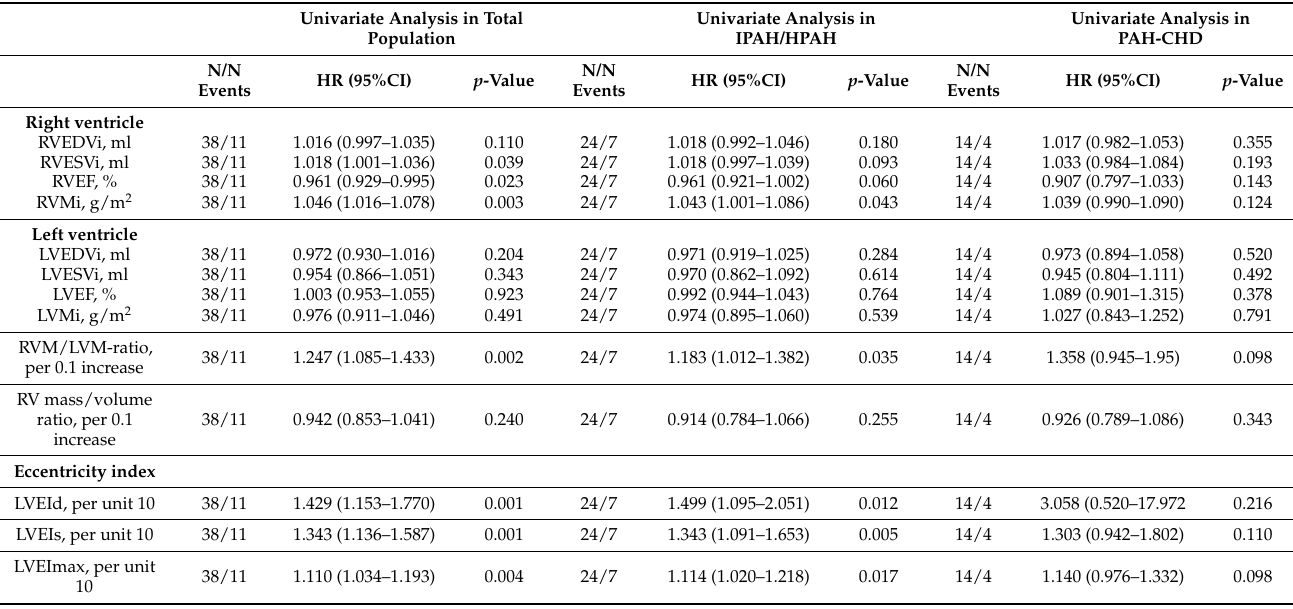
Figure 3. ( A ) Transplant-free survival in the studied cohort of children with PAH. ( B ) Transplant-free survival in children with IPAH/HPAH compared with children with PAH-CHD. From the studied CMR variables, RVEF, RVESVi, RVMi, RVM/LVM-ratio, LVEId, LVEIs and LVEImax were all associated with transplant-free survival from time of CMR in the total group ( p < 0.05) (Table 3). Table 3. Association of CMR characteristics with transplant-free survival in children with IPAH/ HPAH and